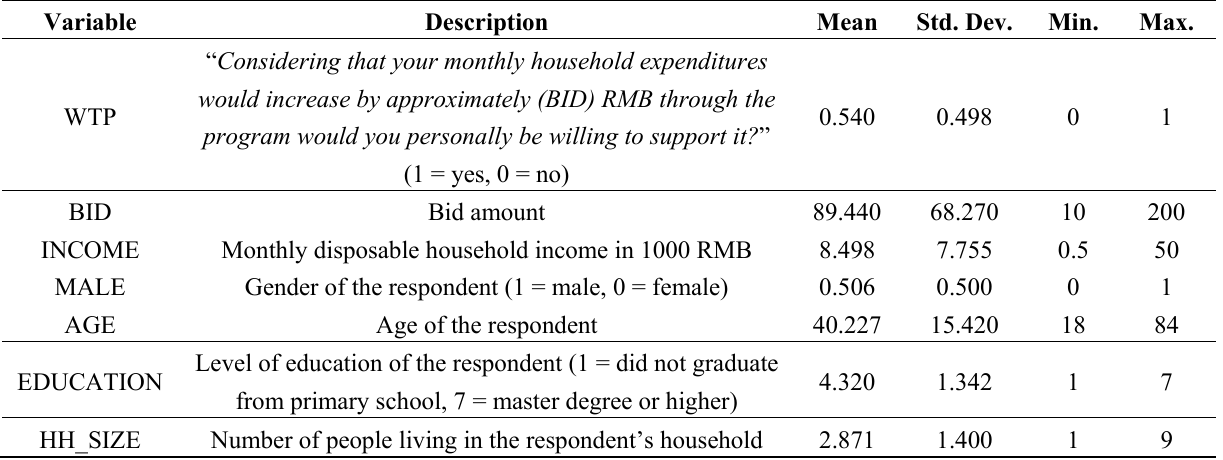
Table A1. Description of variables used in the regression